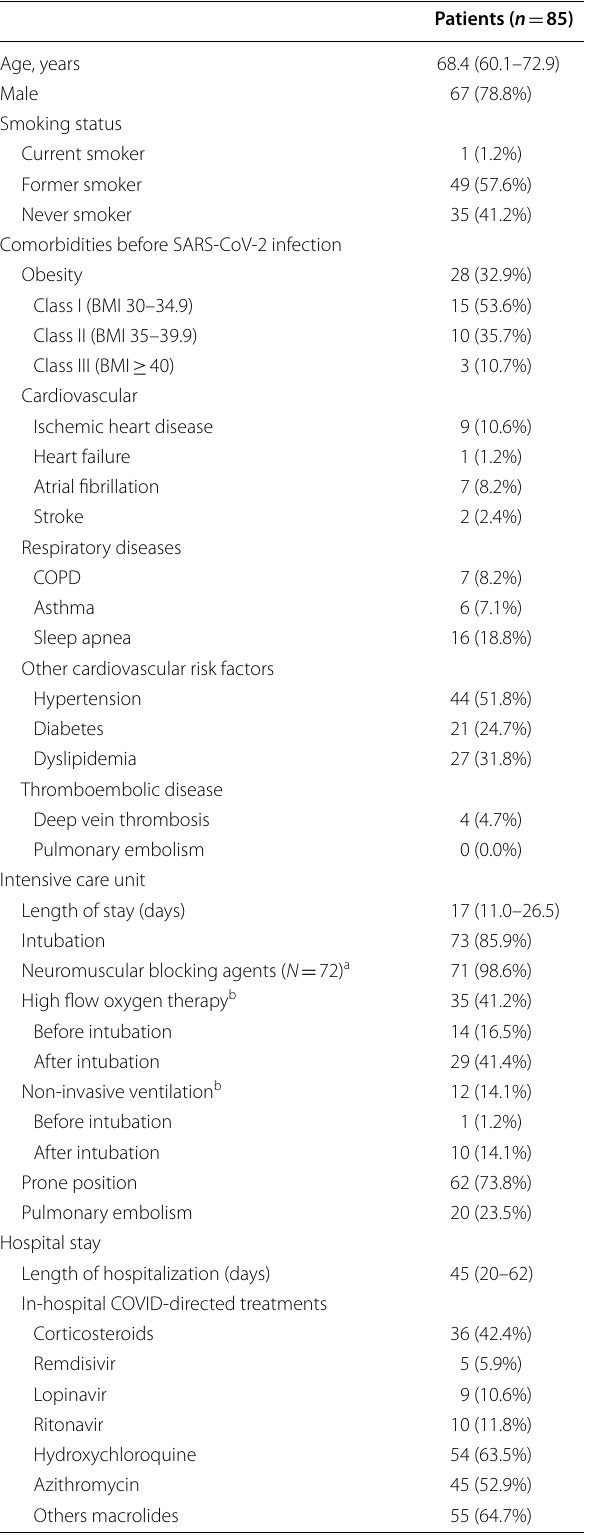
Table 1 Characteristics and medical history at